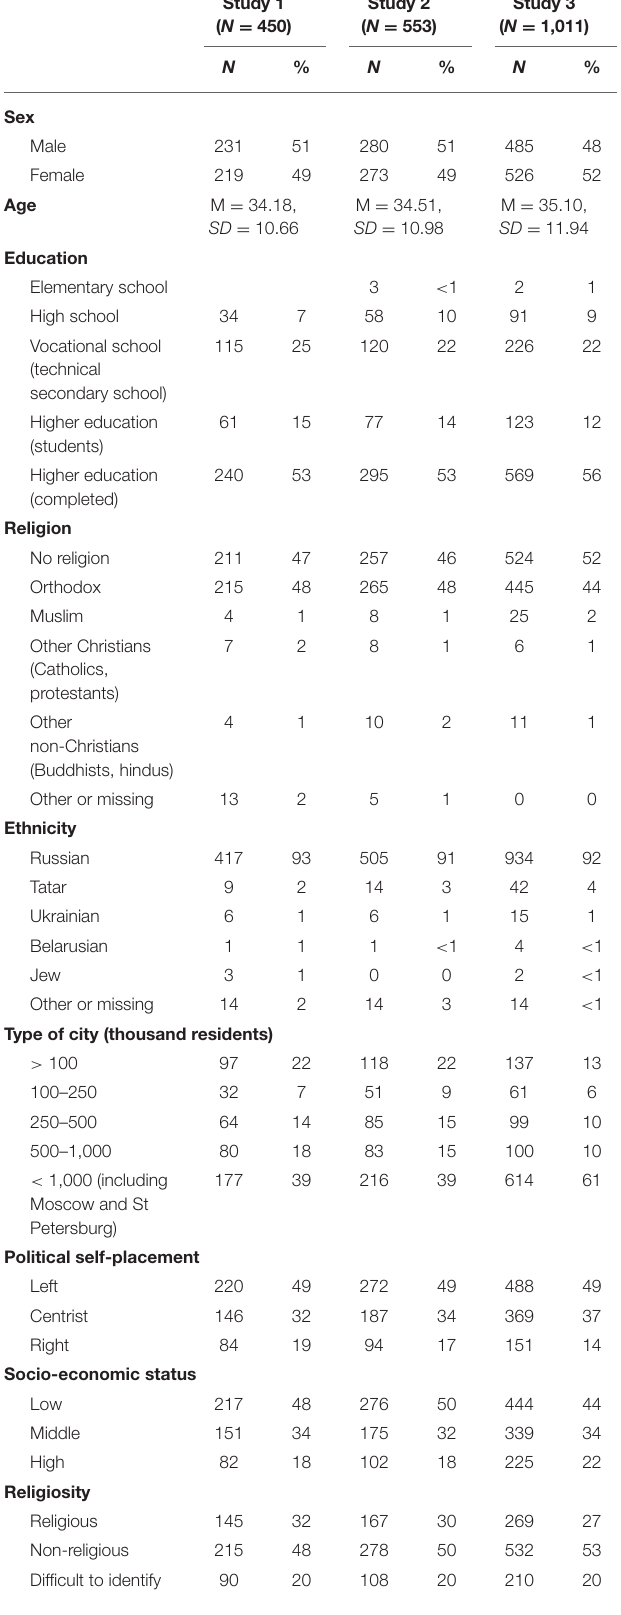
TABLE 1 | The description of the studies samples. TABLE 2 | CFA one-factor goodness of fit indicators of the Russian versions of SJ scales.